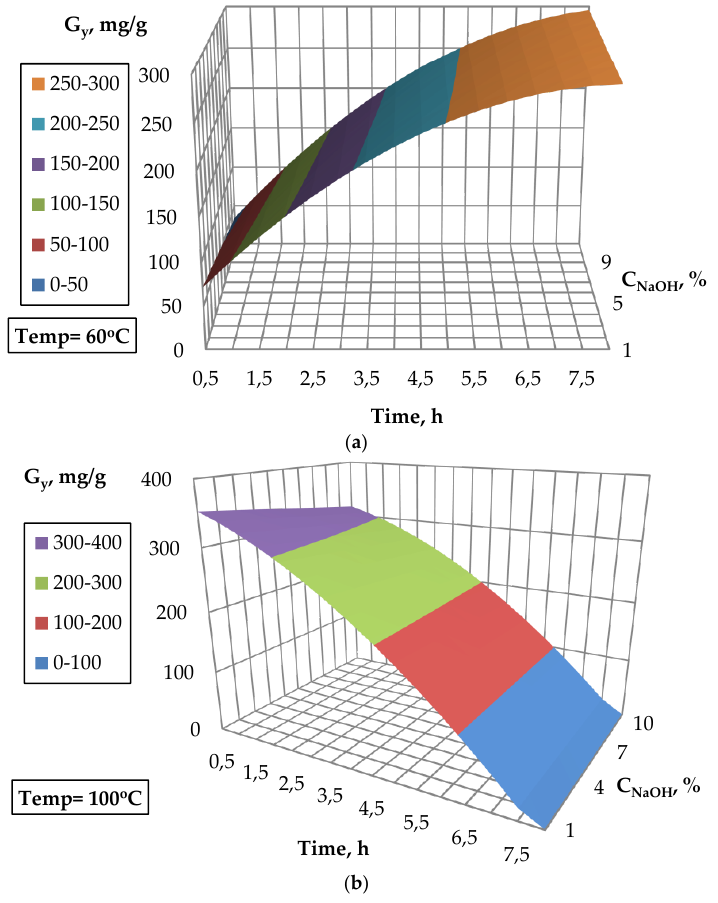
Figure 5. The surface response plots of the effects of NaOH concentration and time acid hydrolysis on the glucose yield: ( a ) at a constant temperature 60 °C; ( b ) at a constant temperature 100 °C.